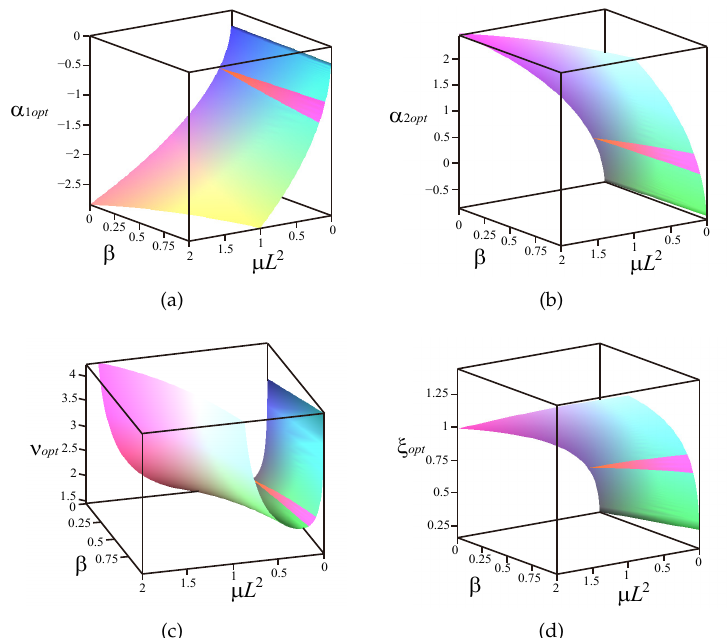
Figure 7. The relationship between optimal parameters and system parameters when α 1 < 0: ( a ) α 1 opt . ( b ) α 2 opt . ( c ) ν opt . ( d ) ξ opt